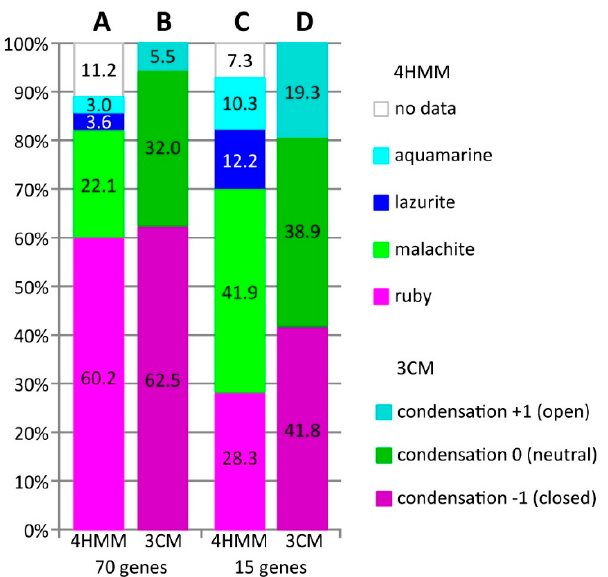
Figure 5. Summed length of four-chromatin states model [39] and three chromatin condensation level model [32] in 70 and 15 studied genes. (A) distribution of chromatin states in 4HMM model in 70 genes (%); (B) distribution of chromatin condensation states in 3CM model in 70 genes (%); (C) distribution of chromatin states in 4HMM model in 15 genes (%); and, (D) distribution of chromatin condensation states in 3CM model in 15 genes (%). Table 1. Fifteen long genes